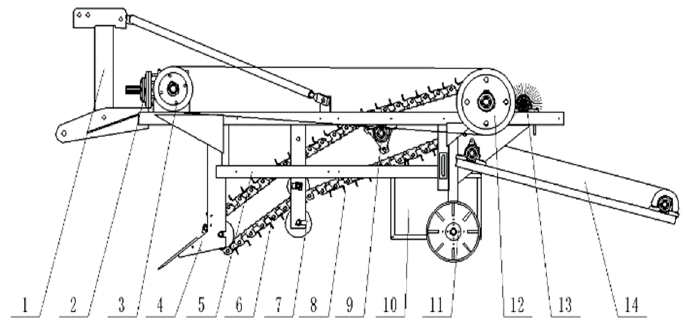
Figure 1. Schematic diagram of the structure of a chain drive residual film recovery mechanism. 1 suspension frame; 2 gearbox; 3 small pulley; 4 film starting mechanism; 5 frame; 6 chain drive film-soil separation mechanism; 7 carrier chain roller; 8 spring tooth; 9 shaking roller; 10 film box; 11 support wheel; 12 large pulley; 13 brush film roller, and 14 secondary film-soil separation device.